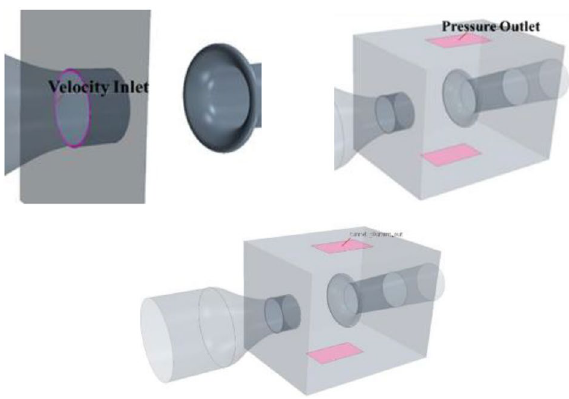
Figure 38. Velocity inlet and Pressure outlet of the flow-follow device.